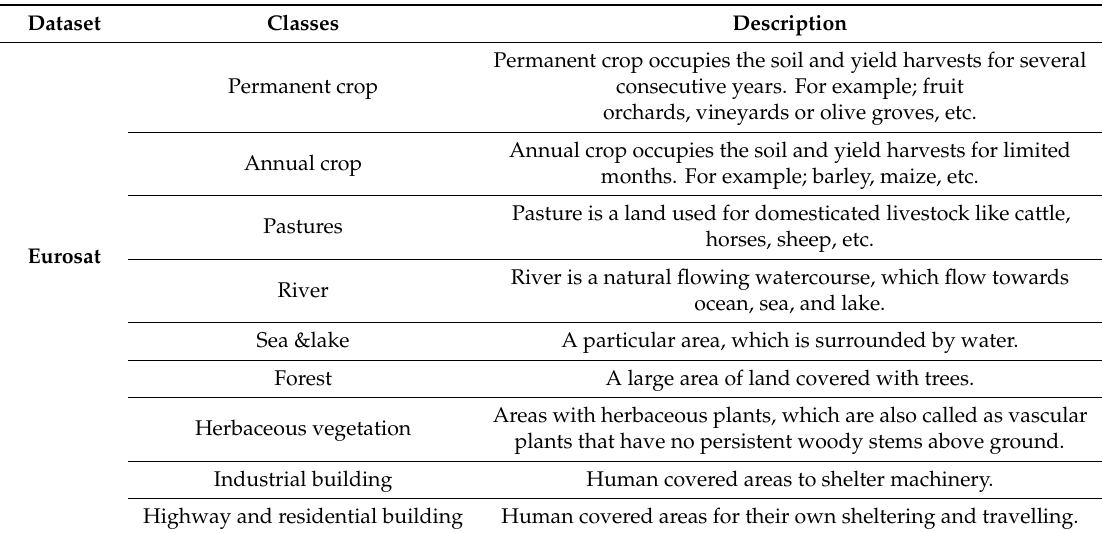
Table 2. Description of land-use and land-cover (LULC) classes in Eurosat